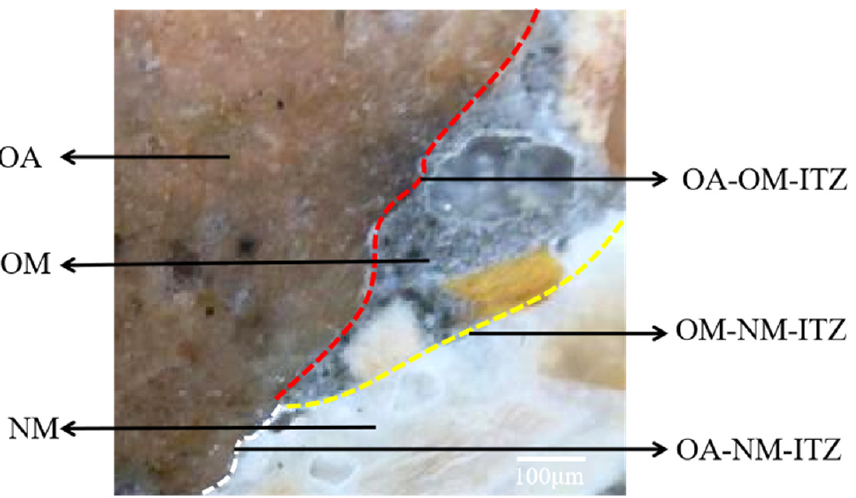
Figure 6. Schematic diagram of interface transition zones (ITZs): OA–order aggregate, OM–order mortar, NM–new mortar, OA-OM-ITZ–the interface between old aggregate and old mortar, OA-NM-ITZ–the interface between old aggregate and new mortar, OM-NM-ITZ–the interface between old mortor and new mortar.